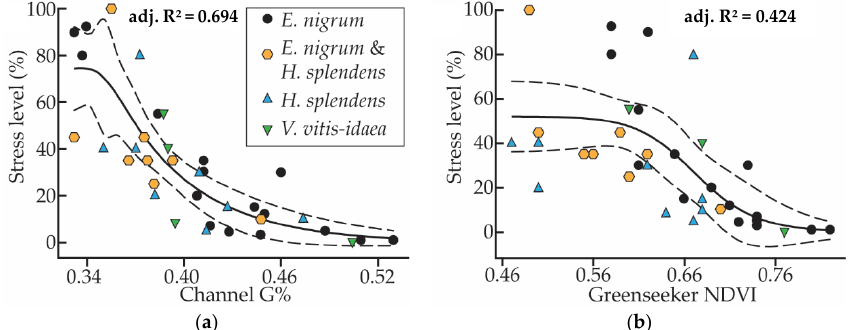
Figure 4. Comparison of stress level to greenness indices. 95% confidence intervals are dashed. Relation between ( a ) stress level and the RGB index Channel G%; ( b ) stress level and Greenseeker NDVI. Equations are shown in Table S4.